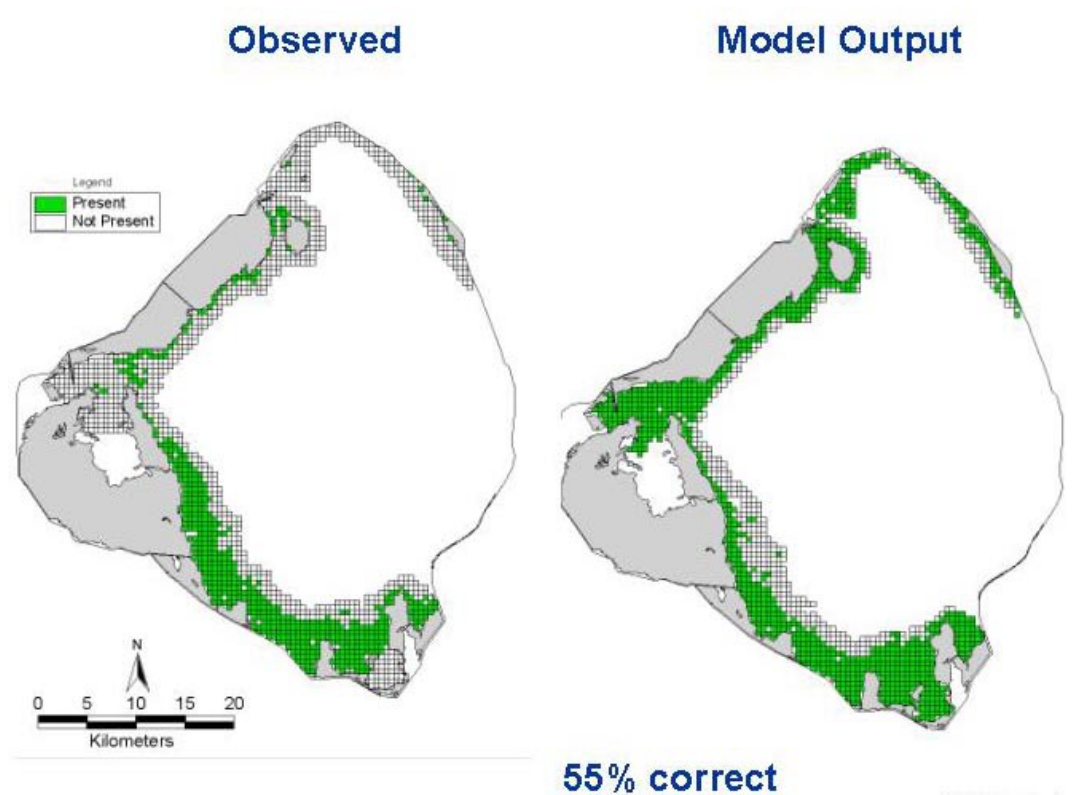
FIGURE 4. Comparison of results of GIS mapping of Chara spp., based on actual observations in late summer 2000 vs. the predictions from (A) a decision model using only water depth as a predictor, and (B) a model using sediment type and then water depth as stepwise predictors. The white area is deeper water that was not